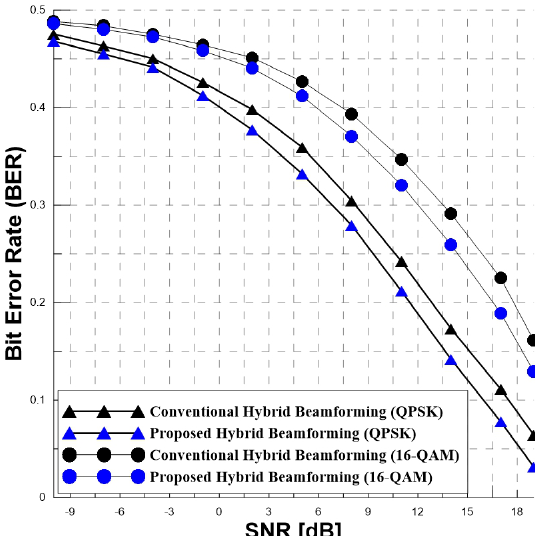
Figure 9. The bit error rate of the hybrid beamforming schemes, N t = 16.